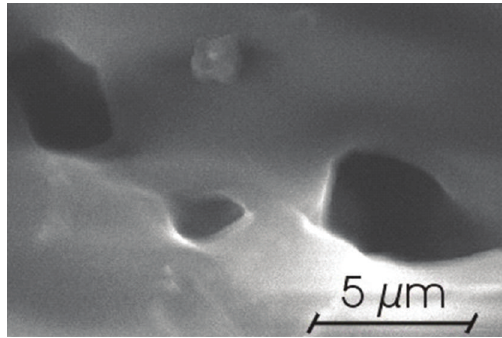
Figure 8: SEM of a cavity found on a Sicopion 35% SFSP mem-